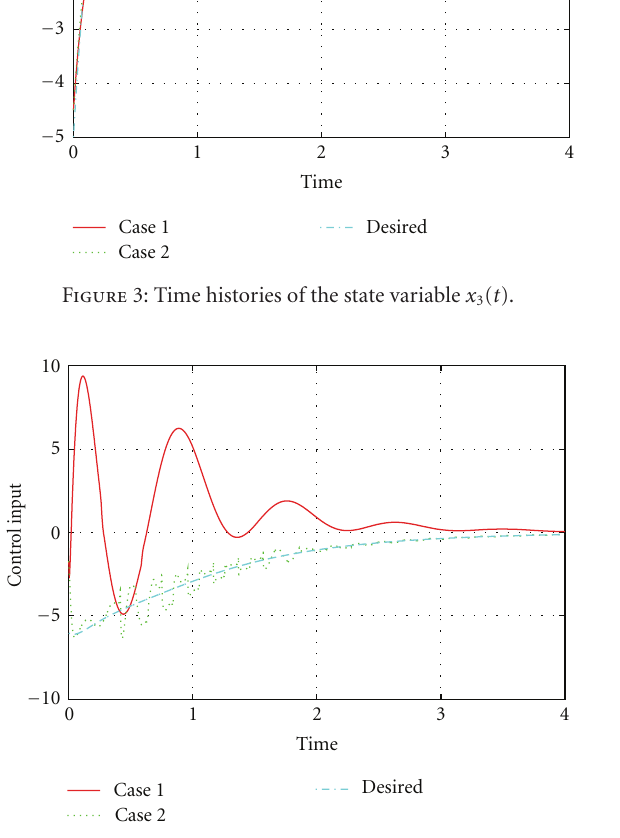
Figure 4: Time histories of the control input u ( t ).